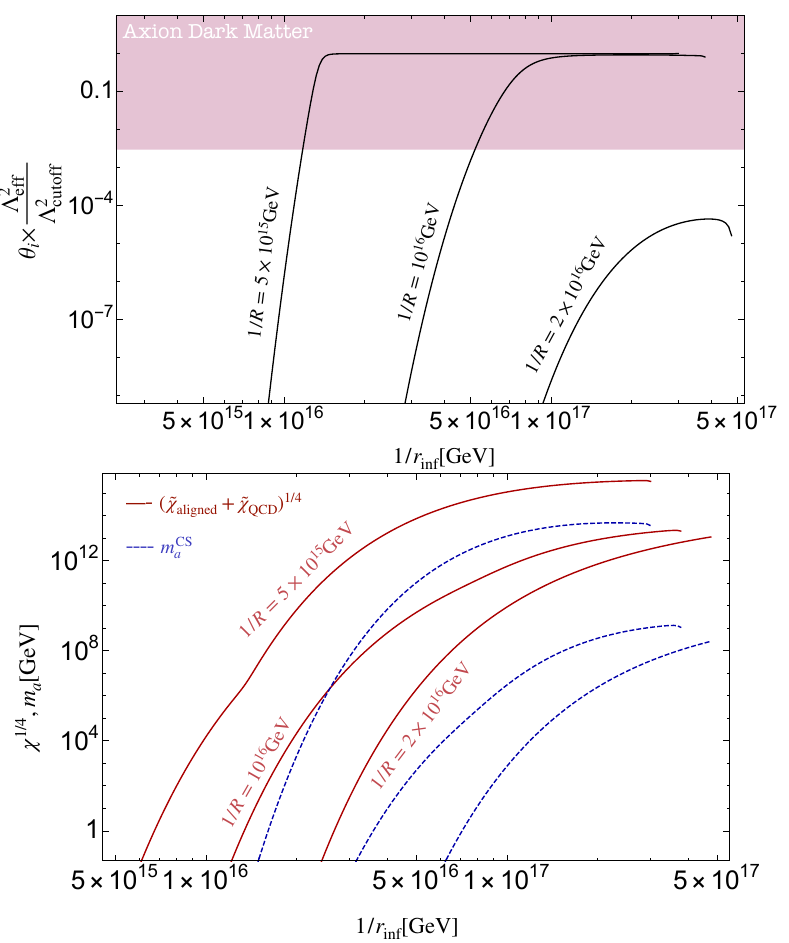
Figure 7 . The resulting misalignment angle of chiral suppression scenario if axion field is set at the potential minimum at r = r inf during inflation [upper panel]. The region can explain the dominant axion dark matter with Λ cutoff / Λ eff . 1 is shown in purple. The corresponding topological susceptibility 1 / 4 [red solid line] and axion mass [blue dashed line] neglecting CPV contribution with general r are also shown [lower